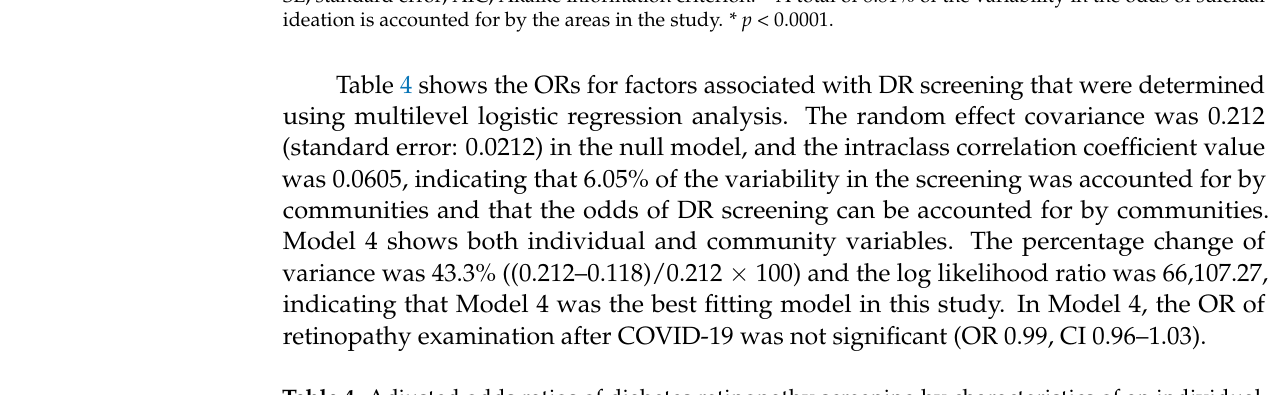
Table 4. Adjusted odds ratios of diabetes retinopathy screening by characteristics of an individual- and area-level, multilevel